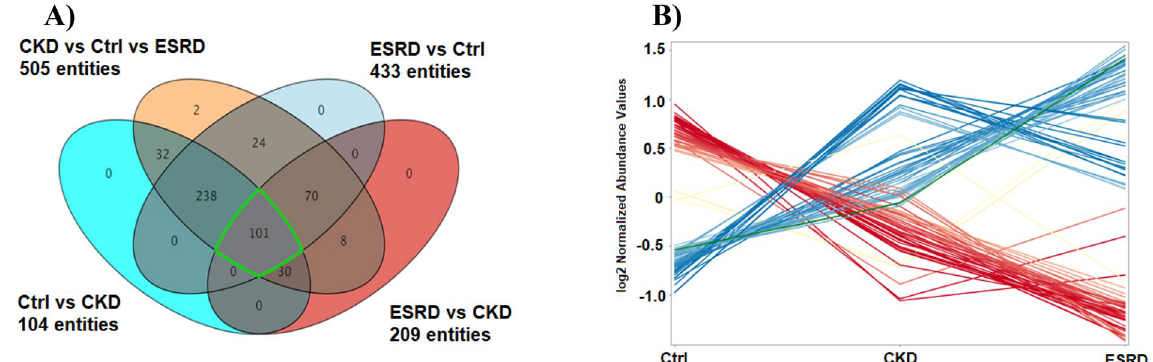
Figure 1. Statistical and fold change evaluation between the study groups control (Ctrl), chronic kidney disease (CKD), end stage renal disease (ESRD)). ( A ) Venn diagram showing One-way ANOVA between the study groups using Tueky’s Post-hoc analysis FDR P < 0.05. ( B ) 101 metabolic features were dysregulated significantly between the study